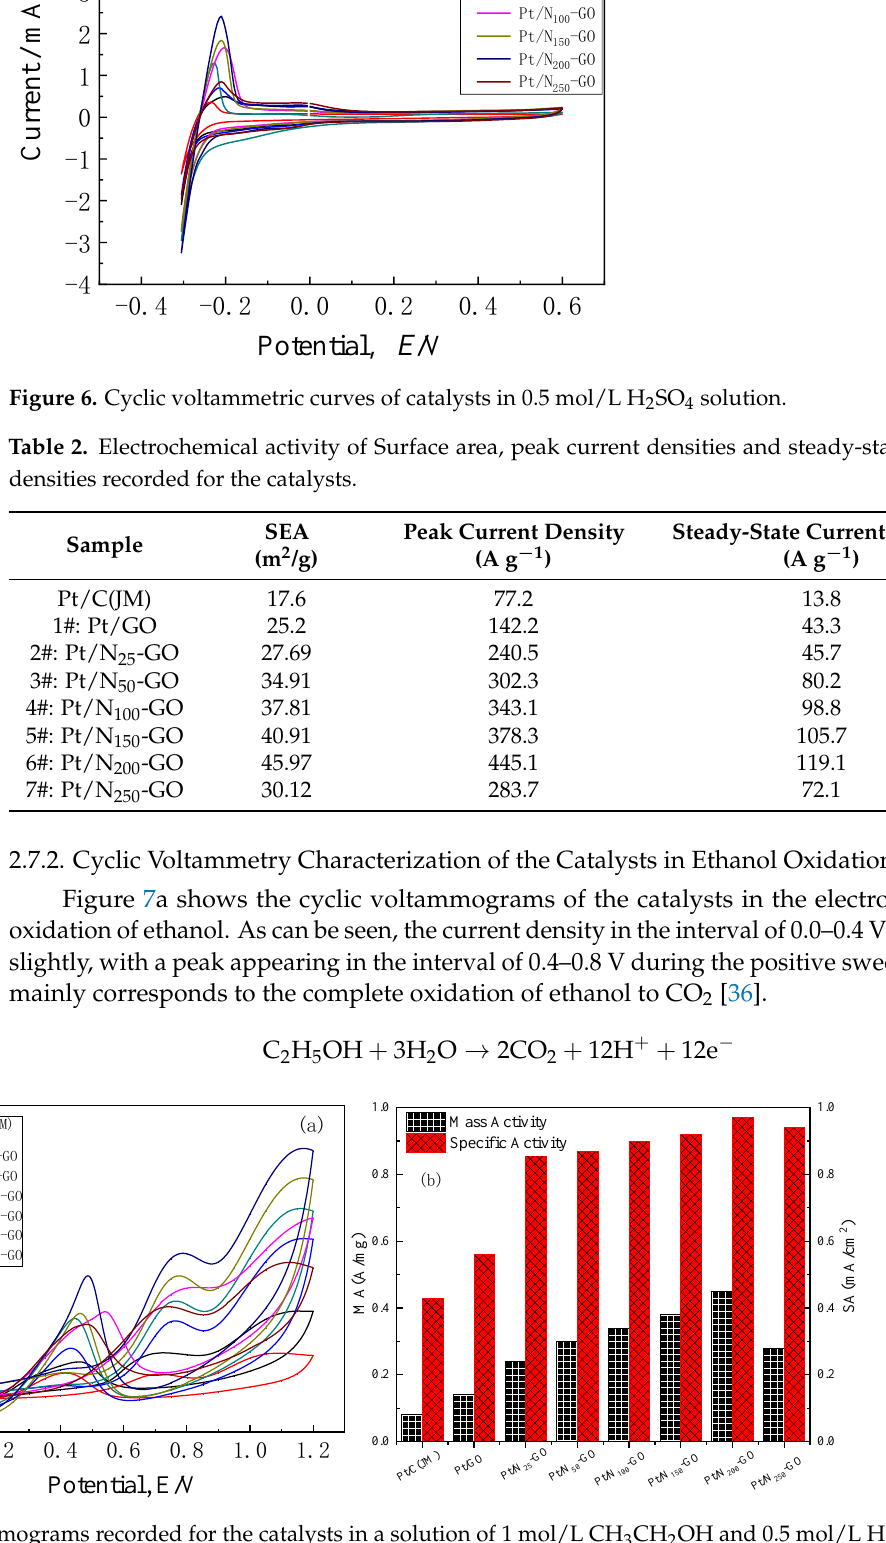
Figure 7. ( a ) Cyclic voltammograms recorded for the catalysts in a solution of 1 mol/L CH 3 CH 2 OH and 0.5 mol/L H 2 SO 4 . ( b ) Histogram of mass activity and specific activity of each group of catalysts.